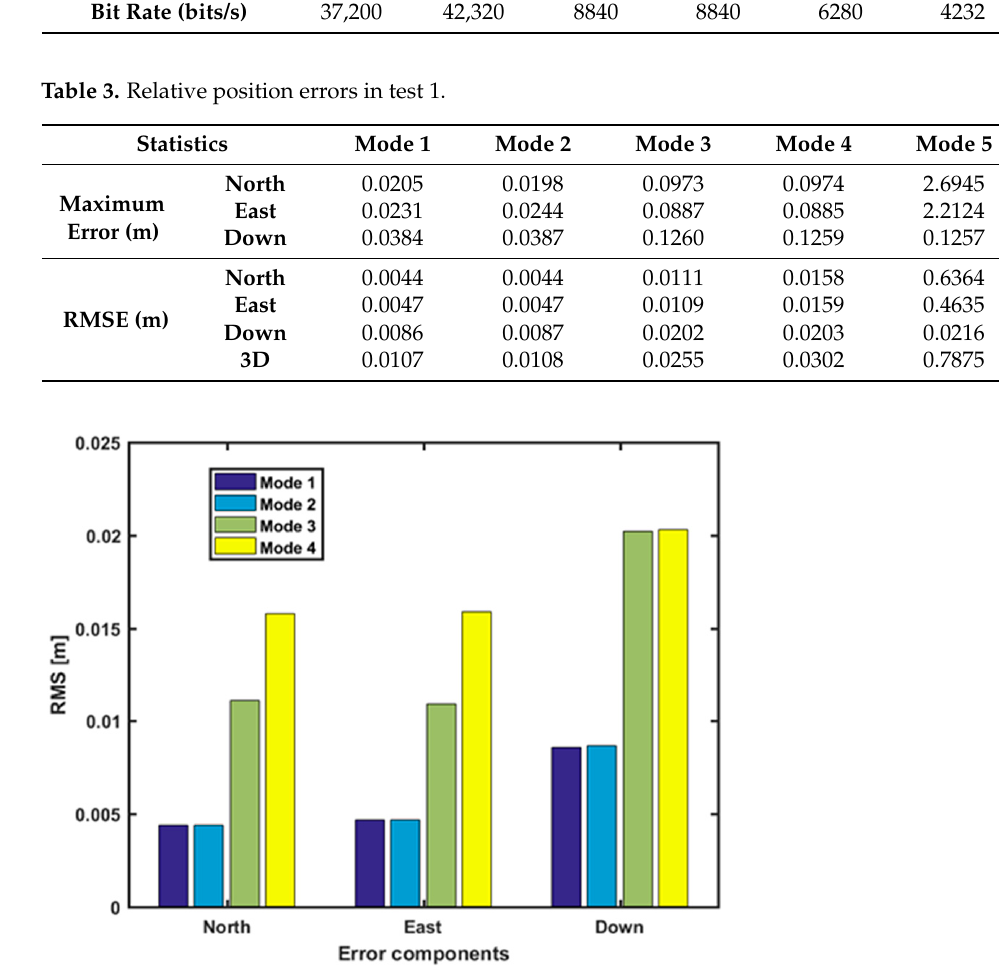
Table 3. Relative position errors in test 1.